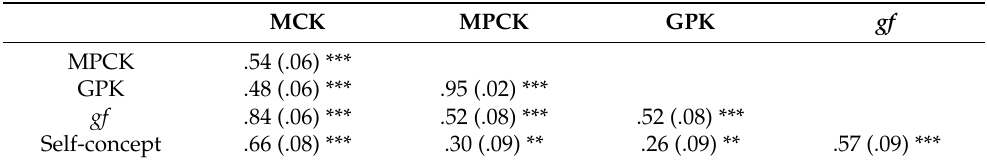
Table 4. CFA model with correlated first-order factor: latent correlations and standard errors (in